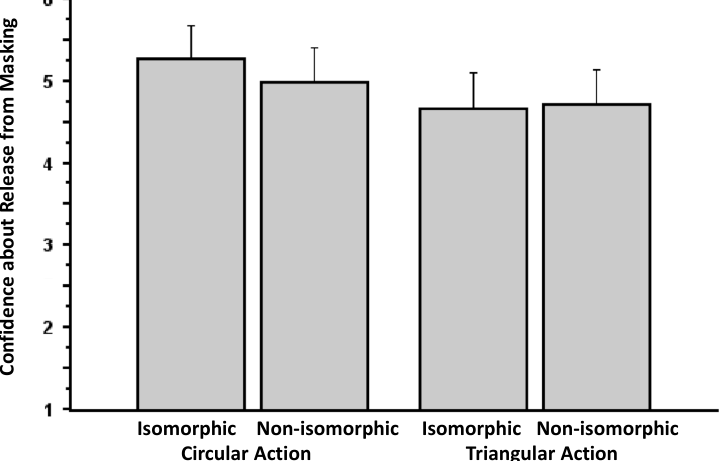
Figure 7. Confidence regarding judgments about release from masking (Experiment